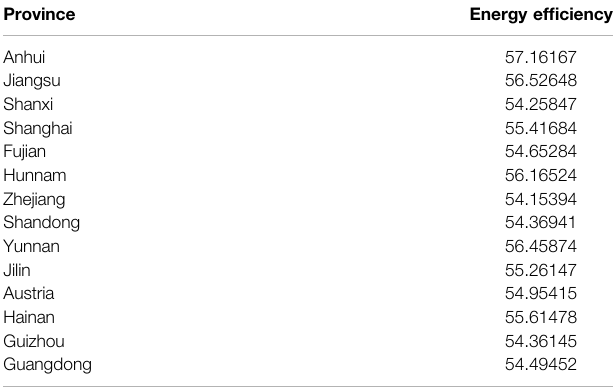
TABLE 7 | Effect of Economic development. Panel A: Main results Economic development inclusion